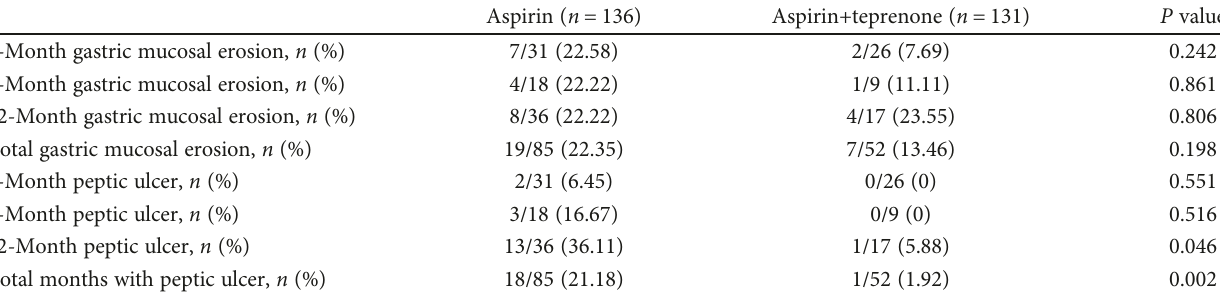
Table 3: Gastroscopy examination results of